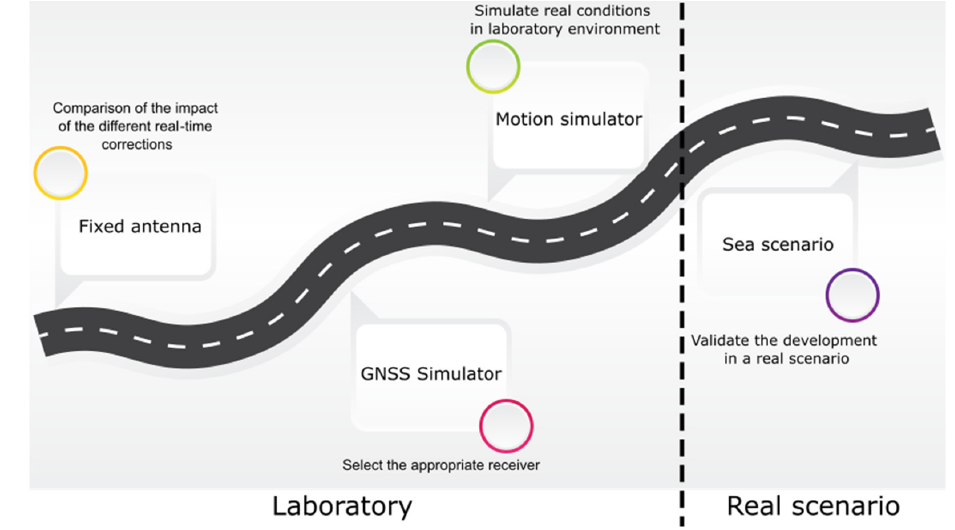
Figure 5. Road map followed in the smart sensor